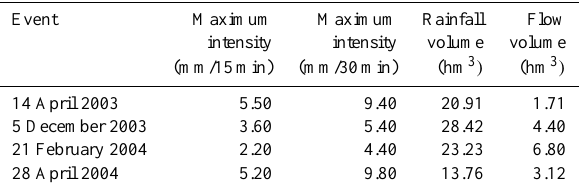
Table 1. Flood events in the Manzanares River basin.